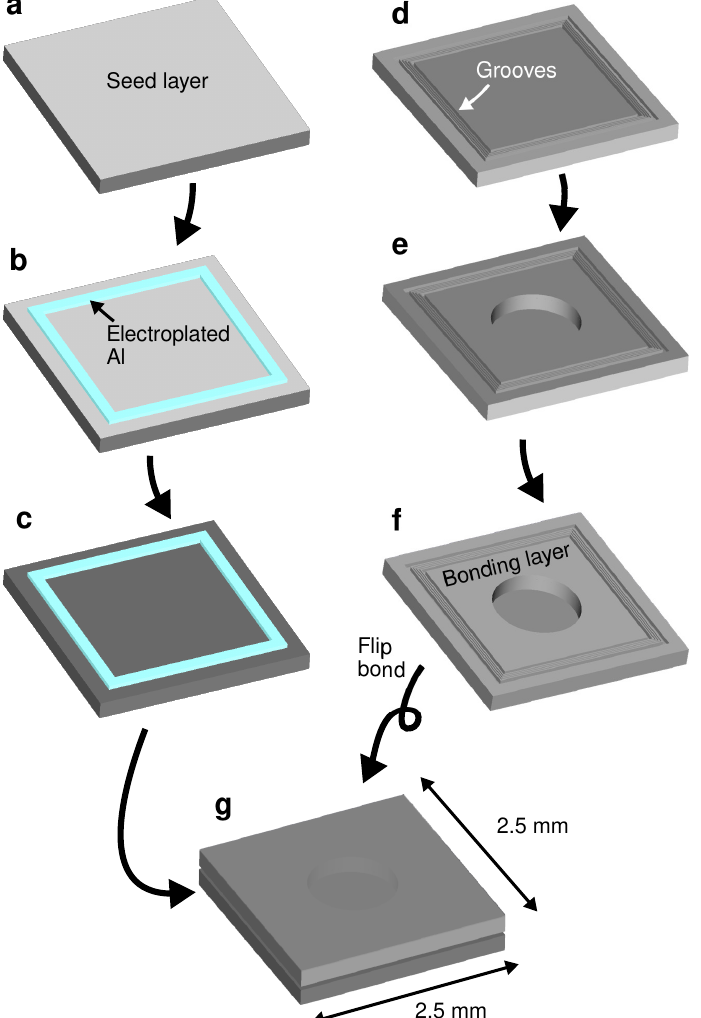
Figure 2. Fabrication process of the test vehicle. ( a ) Electroplating seed layer deposition. ( b ) Al bonding frame electroplating. ( c ) Seed layer removal. ( d ) Groove fabrication on a counter SOI substrate. ( e ) Diaphragm fabrication. ( f ) Bonding layer deposition. ( g ) Wafer